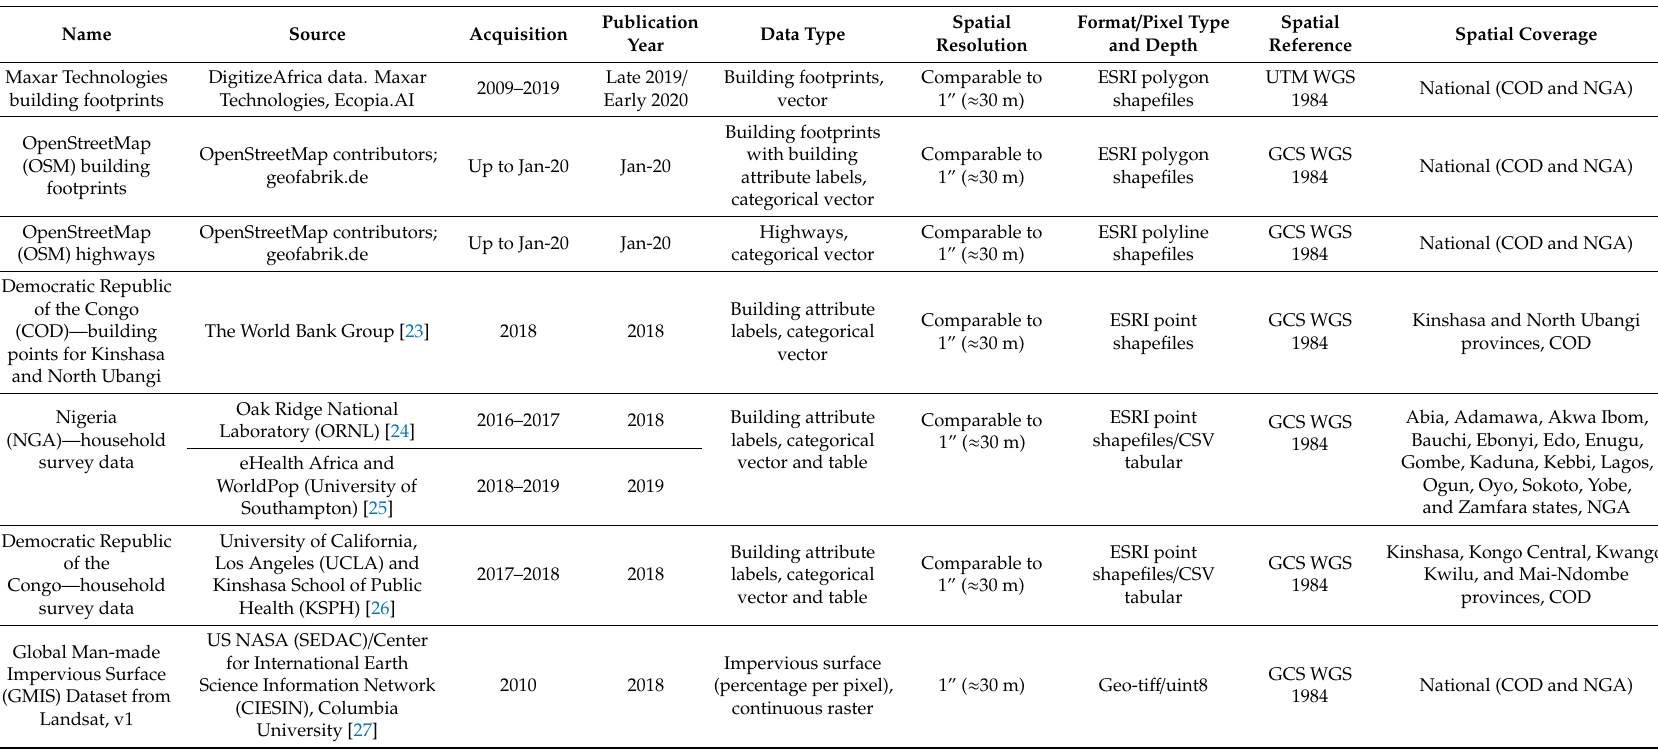
Table 1. Source datasets used as input to the building classification model, either via the GIS workflow or directly. Source datasets are here described. Data source, type, format, and spatial information are